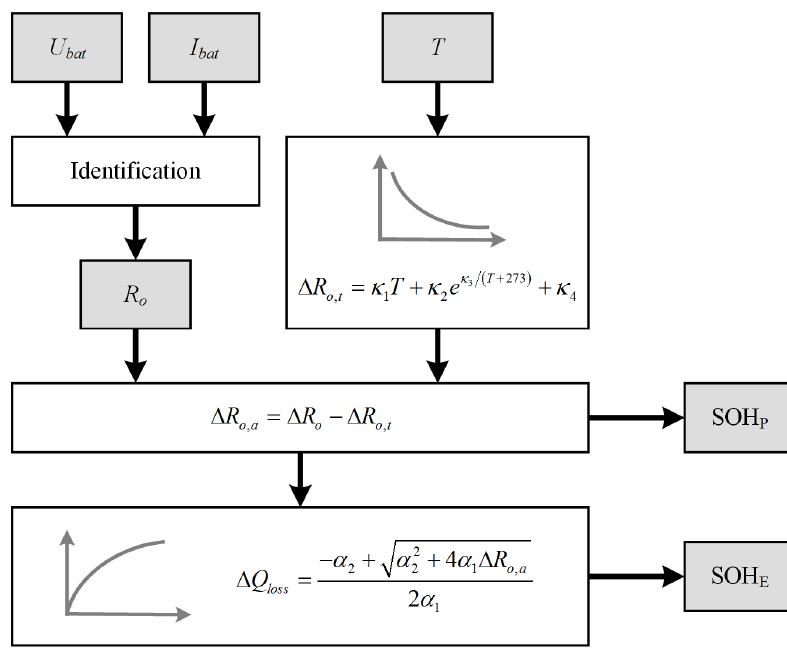
Figure 2. The procedure of the State of Health (SOH) estimation